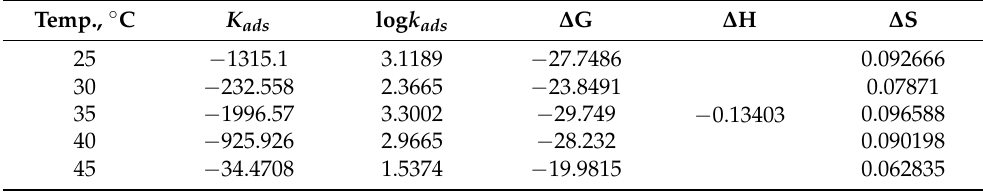
Table 5. Parameters of thermodynamic adsorption of ACR-3 on Cu surface in 1.0 M HNO 3 . Temp., ◦ C